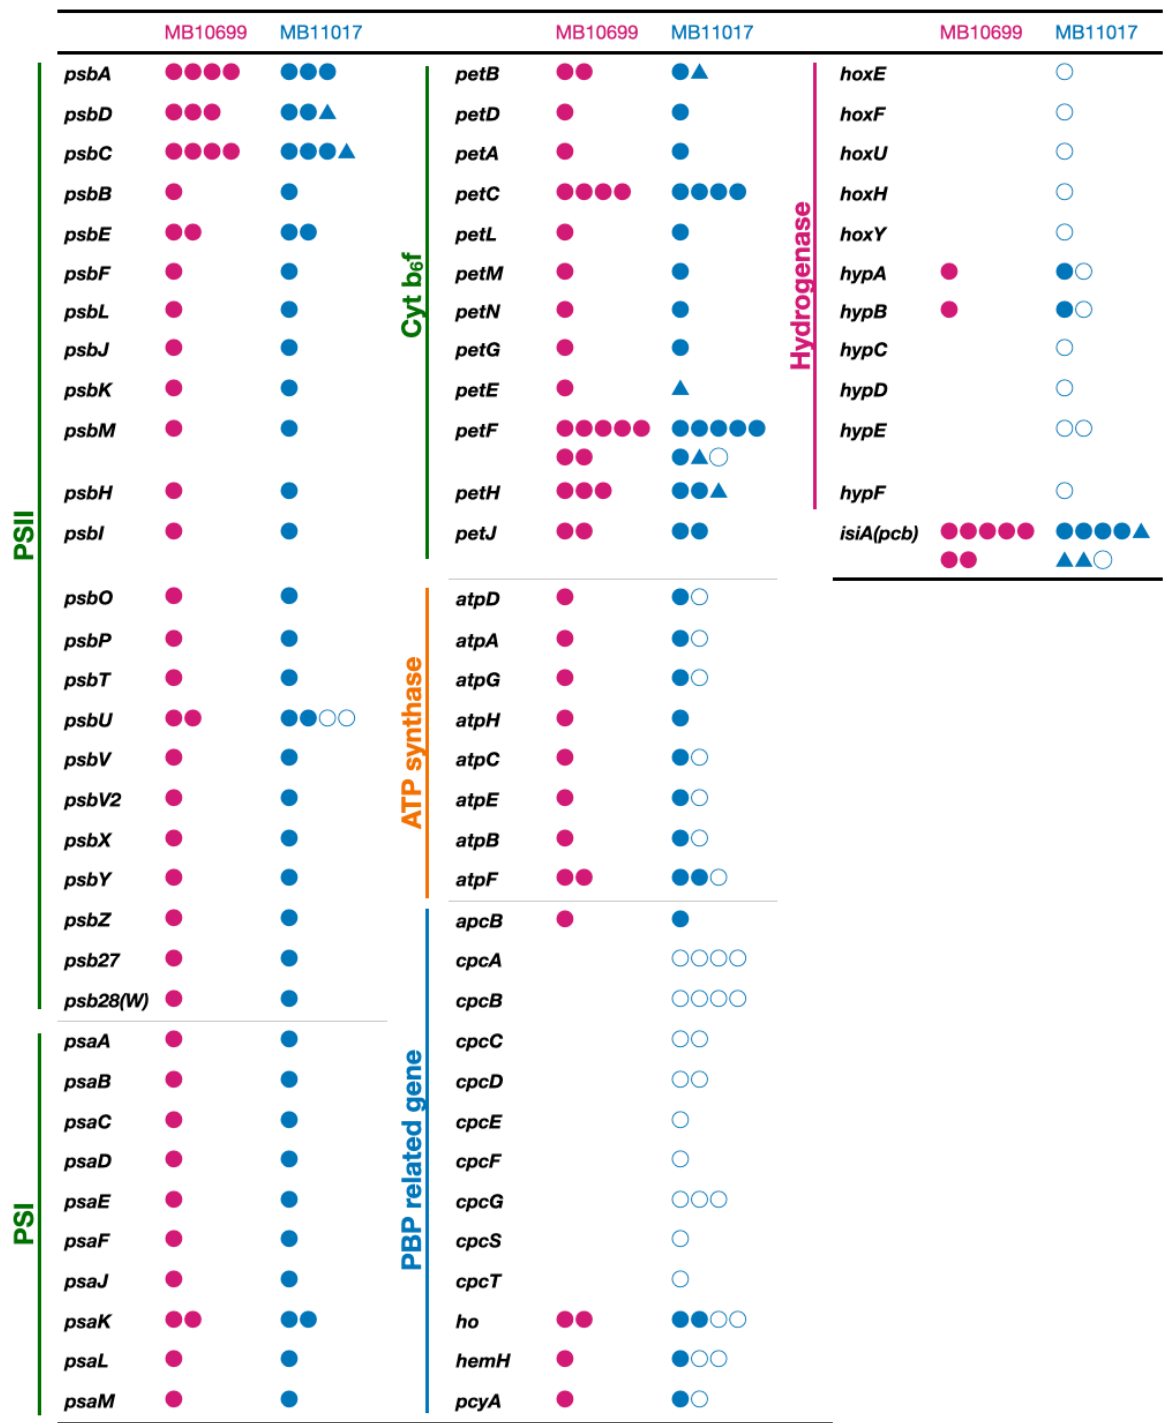
Figure 7. Comparison of the number of gene paralogs related to photosynthesis and electron transfer systems. The number of paralogs of genes related to photosystem I ( psa ), photosystem II ( psb ), cytochrome b 6 f and electron transfer ( pet ), ATP synthase ( atp ), PBP, and hydrogenase are indicated by the number of red ( A. marina MBIC10699) and blue ( A. marina MBIC11017) symbols. Circles indicate completely identical amino acid sequences between the two strains and triangles indicate that the homology is not 100% (shown in A. marina MBIC11017). Filled circles indicate genes encoded by chromosome and empty circles indicate plasmid-encoded